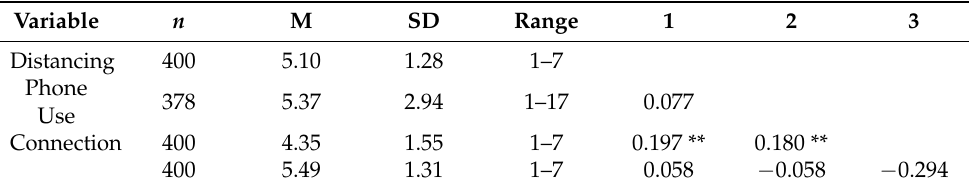
Table 1. Descriptive Statistics and Correlations between Social Distancing, Iphone.Use, Social Connection, and